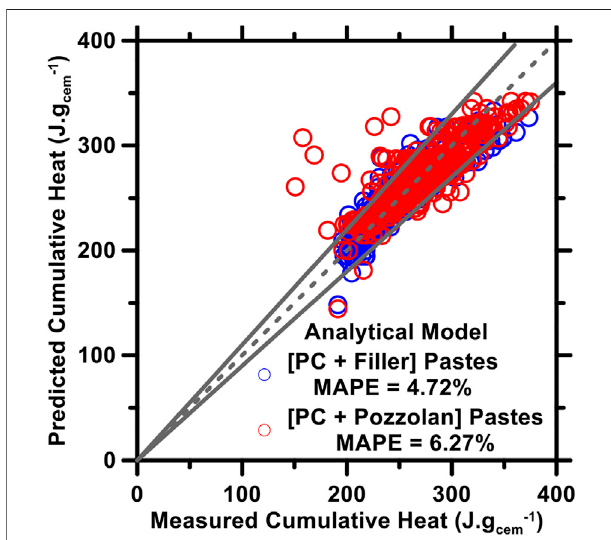
FIGURE 9 | Predictions of 24-h cumulative heat of (PC + pozzolan) pastes and (PC + fi ller) pastes compared against experimental measurements. Mean absolute percentage errors ( MAPE ) of the predictions areshowninthelegends.Thedashedandsolidlinesrepresentthelineof ideality and ± 10% error bounds,